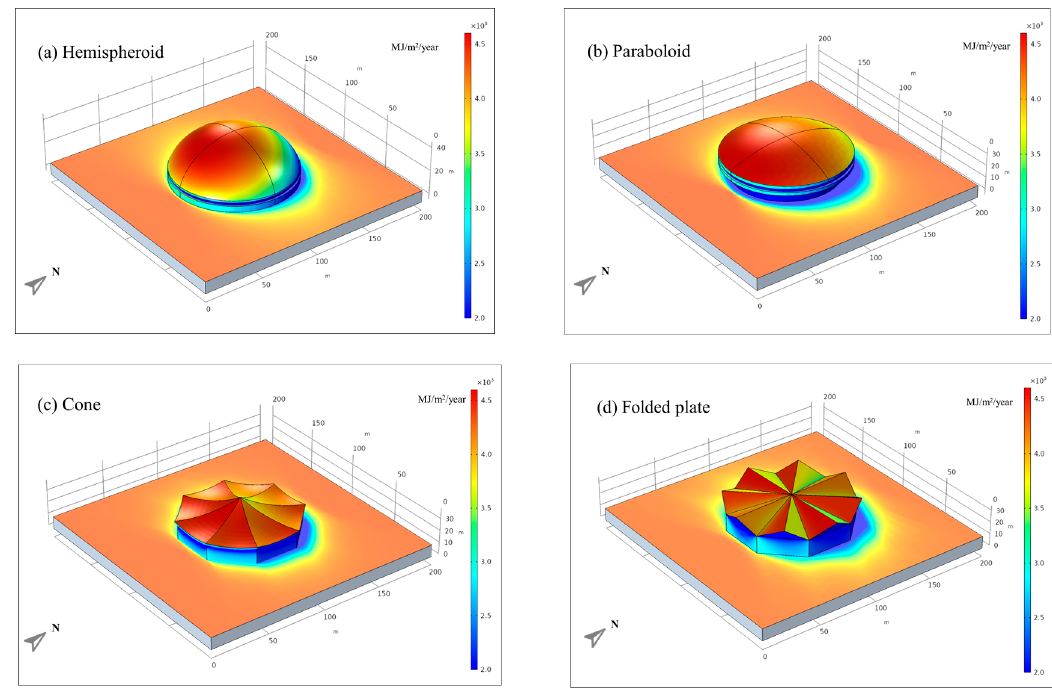
Figure 9. Annual solar radiation intensity of gymnasium buildings with symmetric roof shapes. ( a )